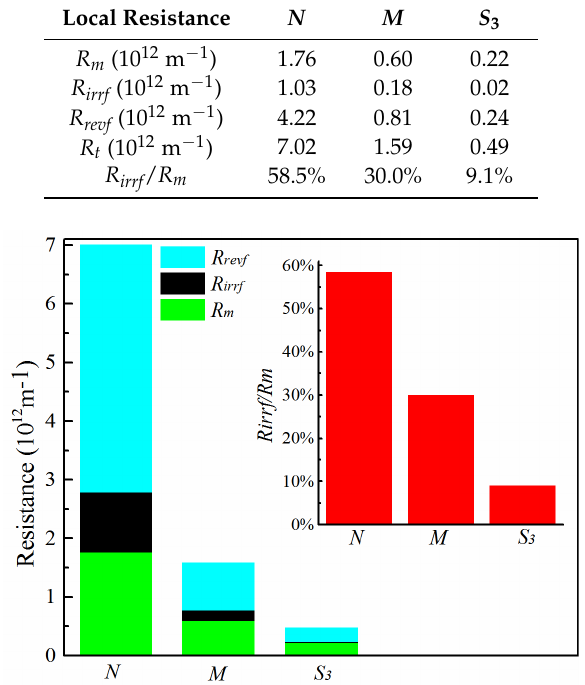
Figure 13. Fouling resistance analysis for membranes N , M and S 3 (total polymer concentration of 20 wt %).